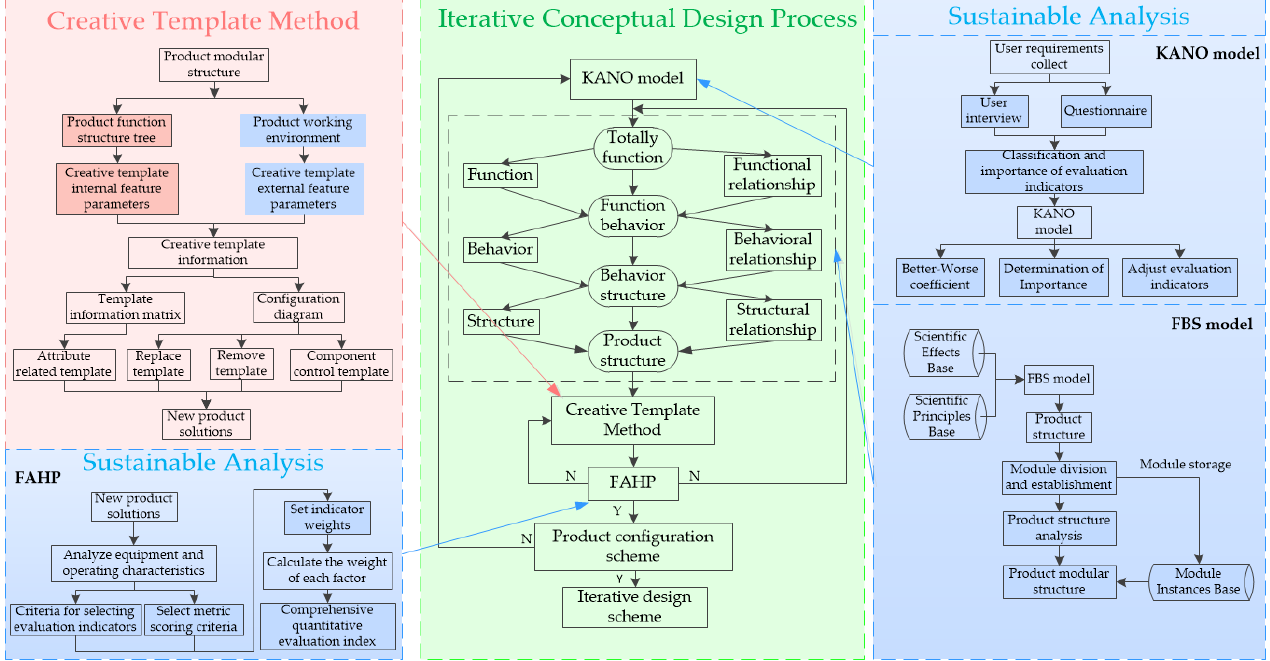
Figure 1. S-KFCF Iterative Conceptual Design Process.